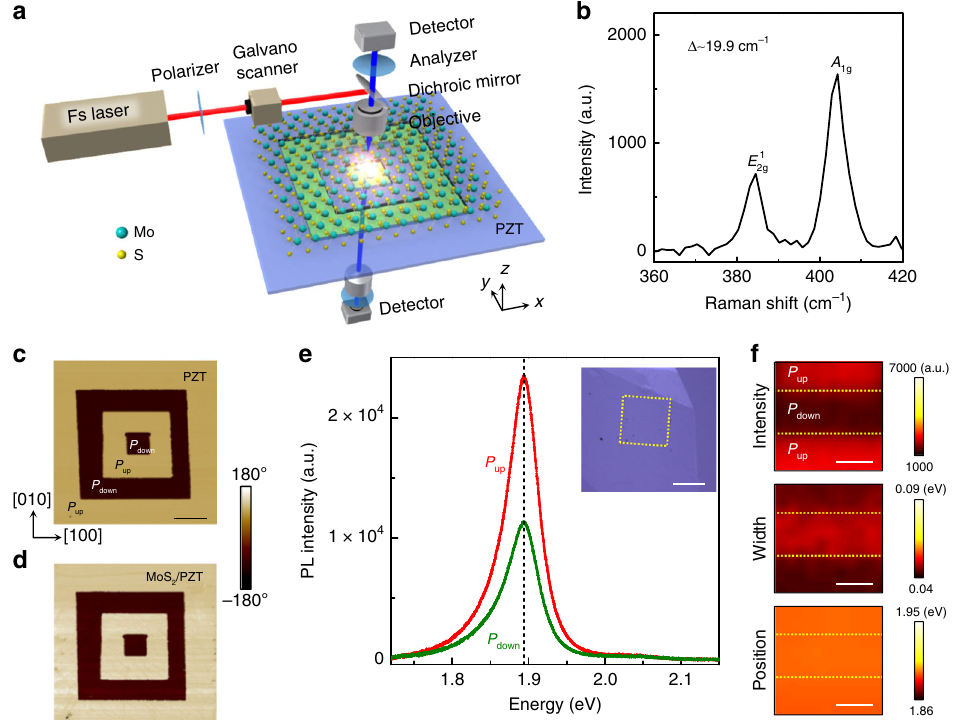
Fig. 1 Characterization of 1L MoS 2 /PZT heterostructures. a Schematic of the SHG experimental set-up. The laboratory coordinate system is shown as inset. b Raman spectrum of a 1L MoS 2 fl ake on gel fi lm showing E 1 mode at 384.0 cm − 1 and A mode at 403.9 cm − 1 . c , d PFM phase images of c square 1 g 2 g domains written on a PZT fi lm and d the same region with a 1L MoS 2 transferred on top. Inset: Crystalline orientation of PZT. The scale bars are 3 μ m. e Room temperature PL spectra of the 1L MoS 2 on the P up and P down domains shown in d . The domain region is outlined in the optical image of the sample (inset). The scale bar is 10 μ m. f PL mapping of the peak intensity (upper), width (middle), and position (lower) on a 1L MoS 2 /PZT sample in a region with both P up and P down domains. The dotted lines mark the DW positions. The scale bars are 2 μ